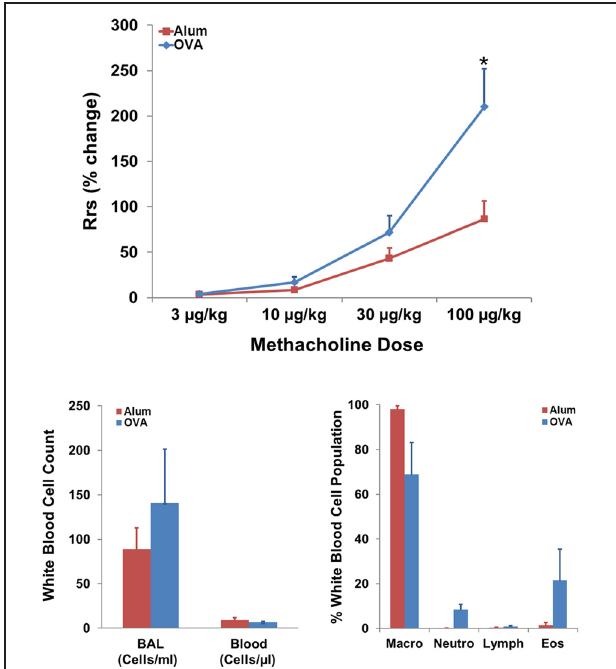
FIGURE 2 | Effect of sensitization on AHR and pulmonary WBC profile. Top panel: OVA sensitization resulted in AHR, measured as an increased percent change in R RS in response to MCh ( t -test; P < 0 . 05). Bottom panels: Effect of OVA sensitization on systemic blood and BAL white blood cell count and BAL differential WBC profile. Non-significant trends toward increased localized pulmonary inflammation, as reflected by modest eosinophilia (Eos) in the OVA group, were observed in analyses of net WBC (bottom left) and white blood cell population breakdown (right panel; percent of population).